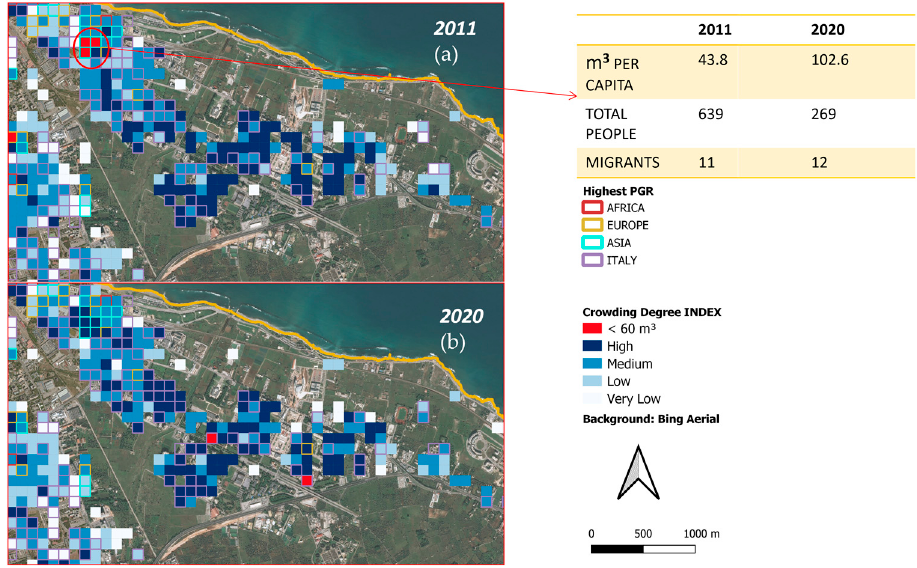
Figure 23. Close-up of Bari residential areas close to old industrial abandoned areas, showing decreasing crowding degree between: ( a ) 2011 and ( b ) 2020.